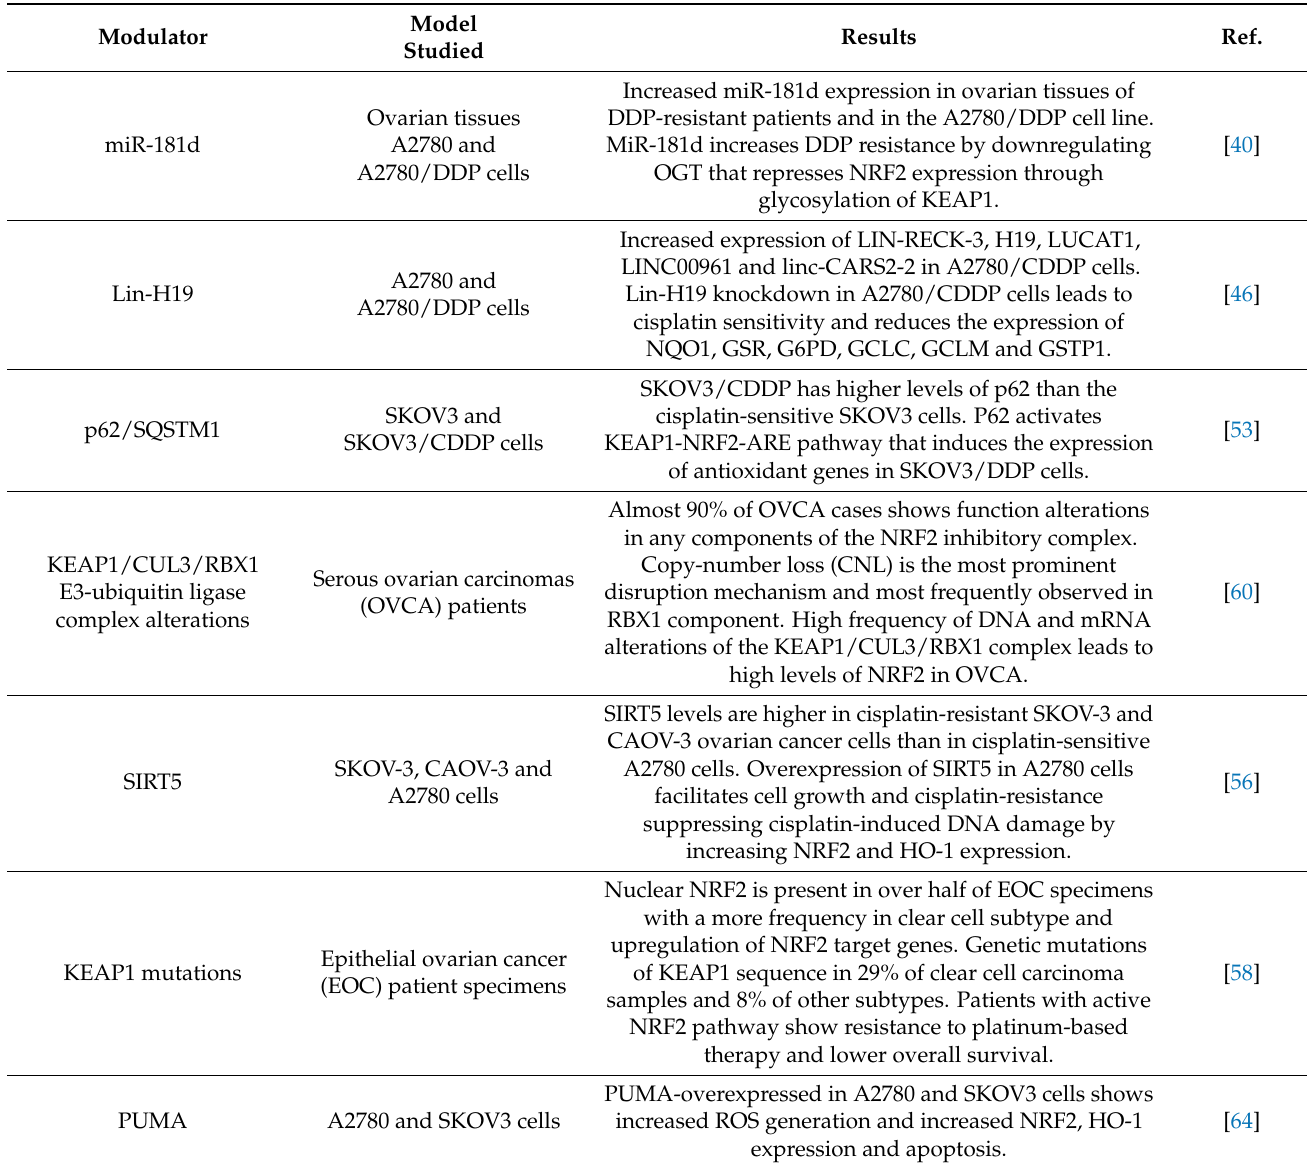
Table 2. NRF2 cellular modulators in ovarian